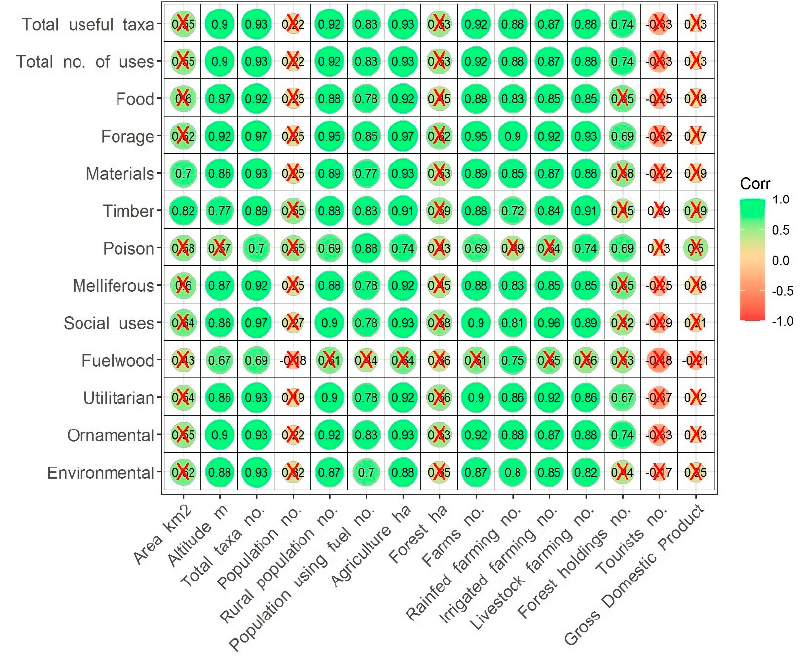
Figure 2. Spearman correlation coefficients between useful taxa (total number and classes of use) and geographic, demographic and economic indicators. Color-coded correlation scale is provided on the right of the plot (green represents positive correlations, and red represents negative correlations); darker color tones and larger circles represent larger correlation coefficients. Values marked with an X are not statistically significant ( p -value > 0.05).